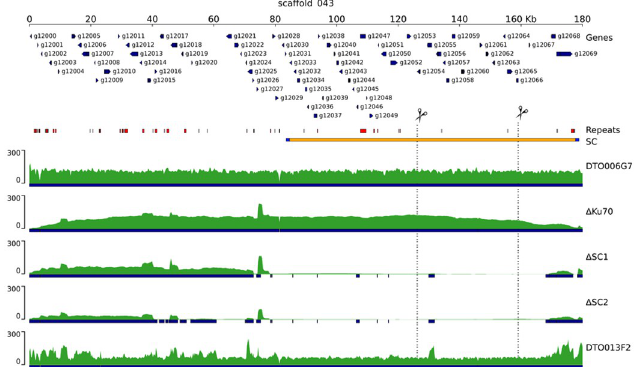
Fig 8. Schematic overview of SORBUS sequences of the knockouts strains. Strains DTO006G7, DTO013F2 and knock-out strains DTO013F2 Δ kusA , SC1 and SC2 are depicted. Predicted genes are indicated with arrows, repetitive DNA is indicated in red, the sequence read coverage is indicated in the green tracks, and blue bars indicate (partial) overlap with DTO006G7. The orange bar indicates the targeted knock-out region (target), flanked by the 5’ and 3’ ends (in blue). Dotted lines and scissors indicate the loci targeted by the sgRNAs.